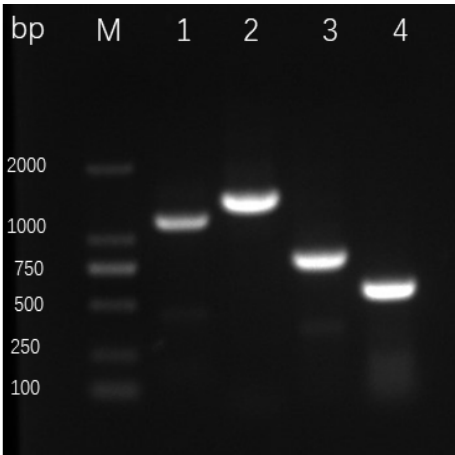
Figure 3. Detection of antibiotic genes in ST–TJ4 by PCR amplification (lane M, DNA marker; 1, PCA; 2, PHZ; 3, PRN; 4, PM).